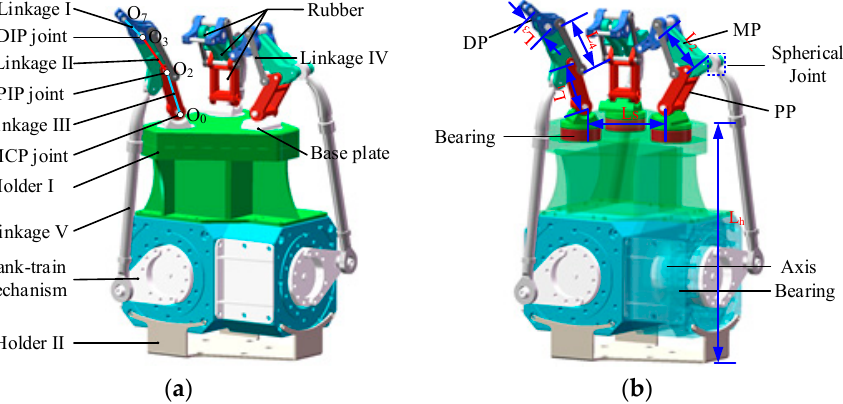
Figure 2. Structural diagram of the underactuated gripper. ( a ) Component Diagram of the underactuated gripper. ( b ) Geometric parameters of the underactuated gripper.